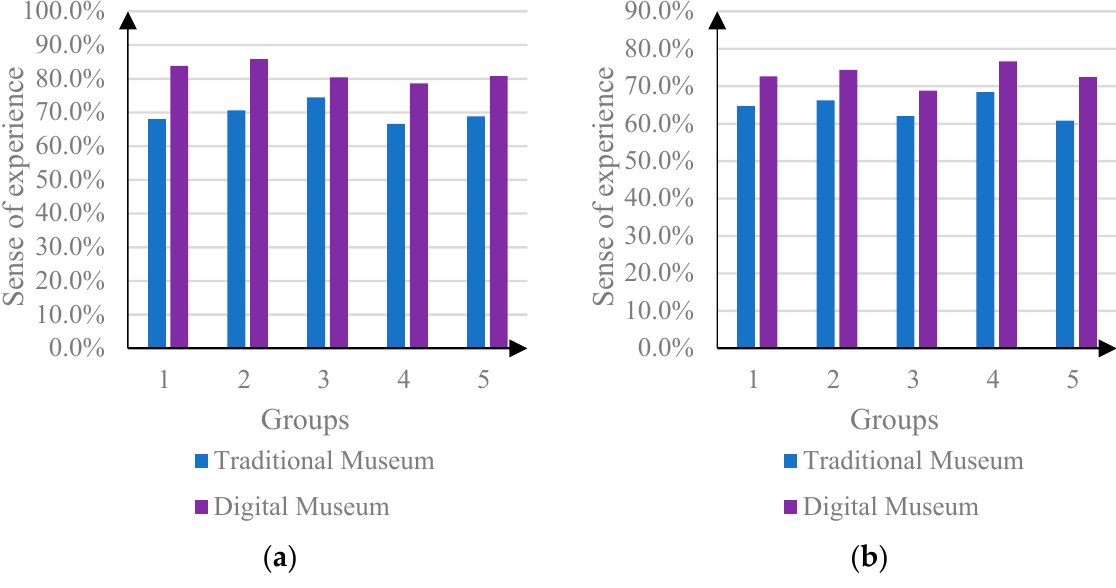
Figure 7. Comparison results of sense of experience. ( a ) Young people’s experience of museums ( b ) Older people’s experience of museums.